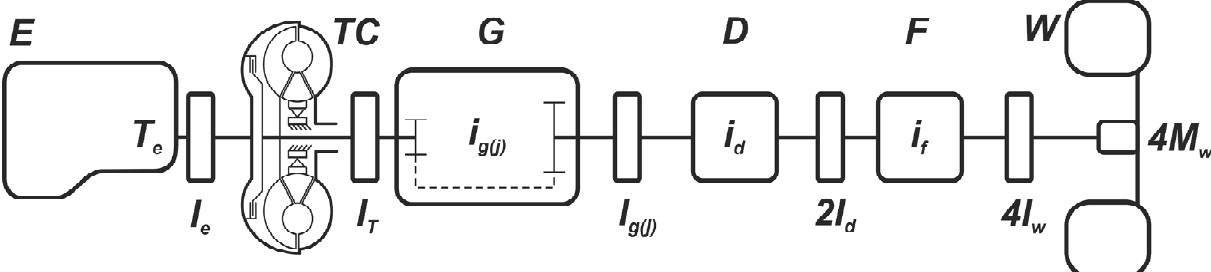
Figure 4. Scheme of conditional structure for all-wheel drive automatic transmission: E — engine, TC — torque converter, G — gearbox, D — drive of inter-axle differential, F — final gear, and W — wheels. The composed dynamic equations for the drivetrain model are shown in Figure 4.